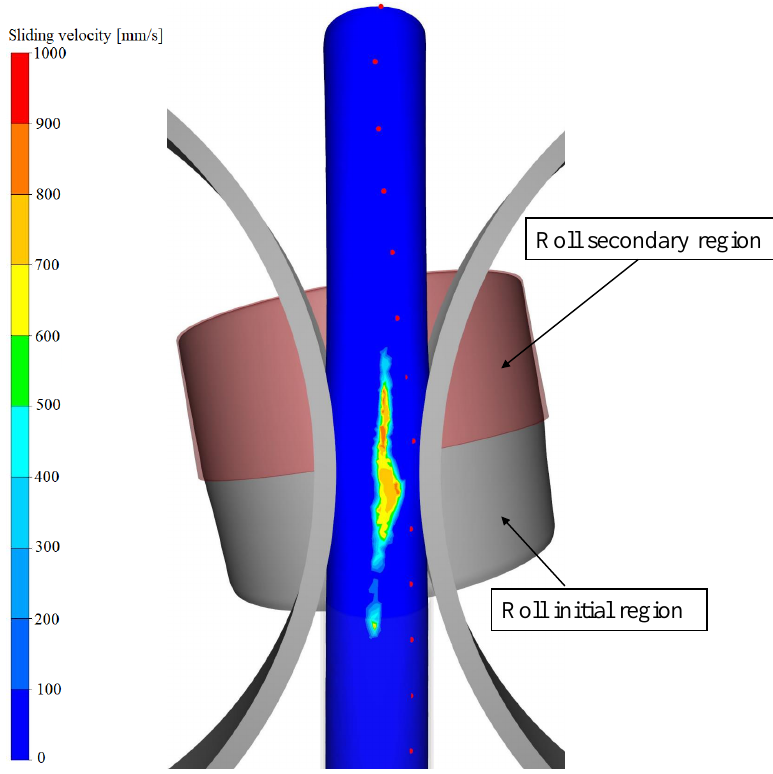
Figure 12. Relative velocity in the roll-billet